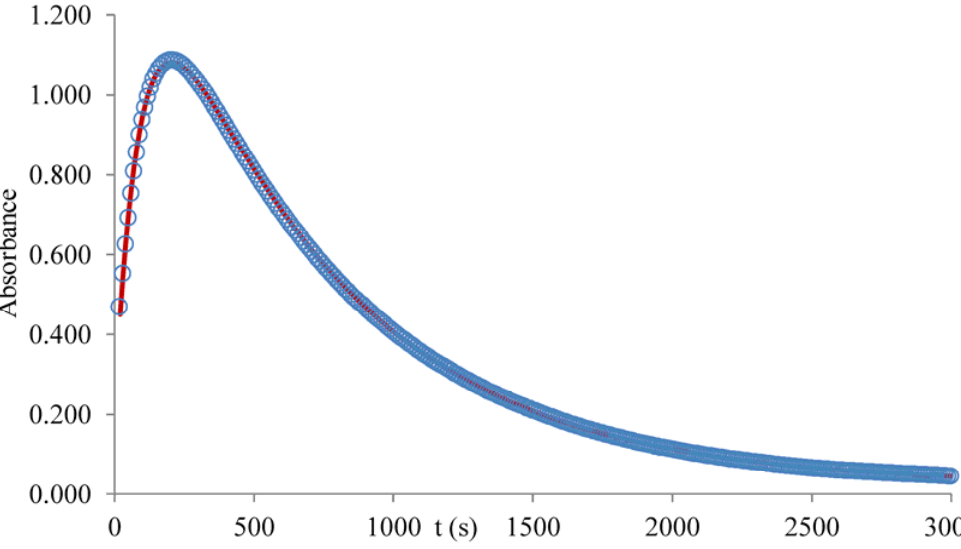
Figure 2. Observed (Circles) and simulated (solid line) absorbance–time trace at 460 nm of a mixture of 1.02 ± 0.05 mM Cr(VI) and 15.0 ± 0.8 mM glutathione in 100 mM glycine (pH 2.8). The calculated absorbances are based on Equation (9). The parameters used to plot the simulated curve are a = 2.4 × 10 − 2 , b = − 1.4, k 1 = (1.0 × 10 − 1 ) s − 1 , c = 1.6, and k 2 = (1.5 × 1 − 3 ) s − 1 .